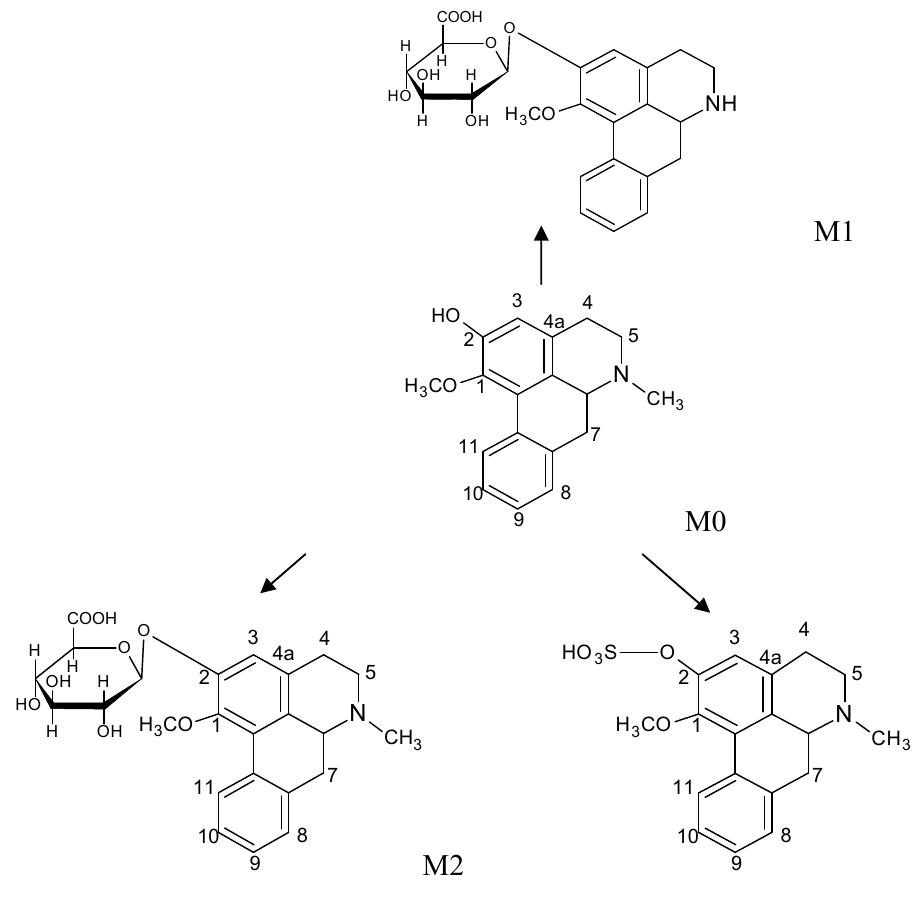
Figure 9. The main metabolic pathway of 2H1M (M0); M1~M3–phase II